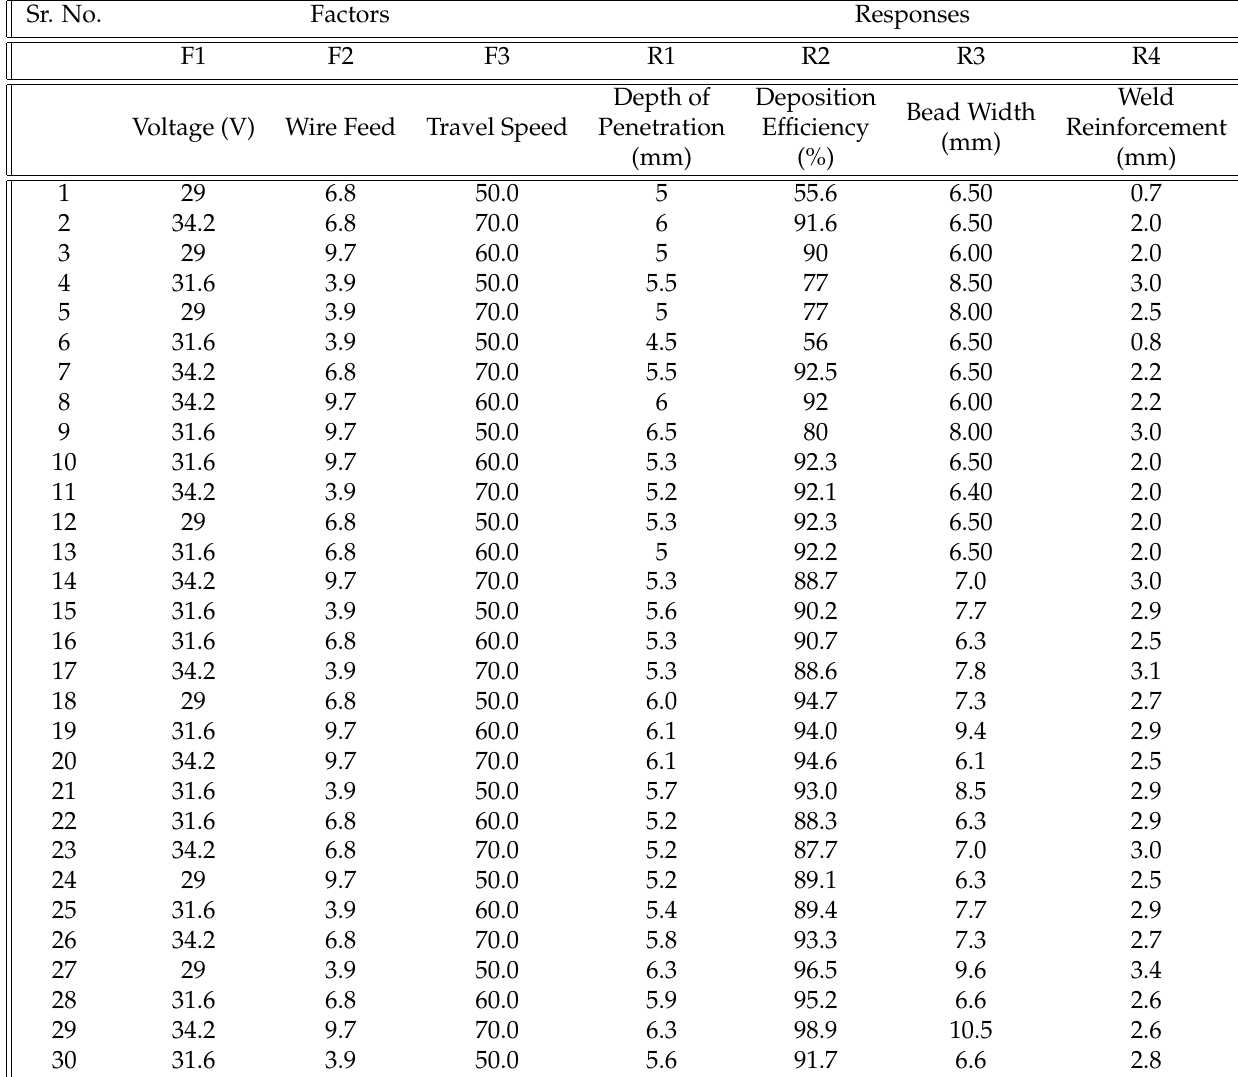
Figure 2. Joint Design Detail used for GMAW Welding Table 4. GMAW data for optimization